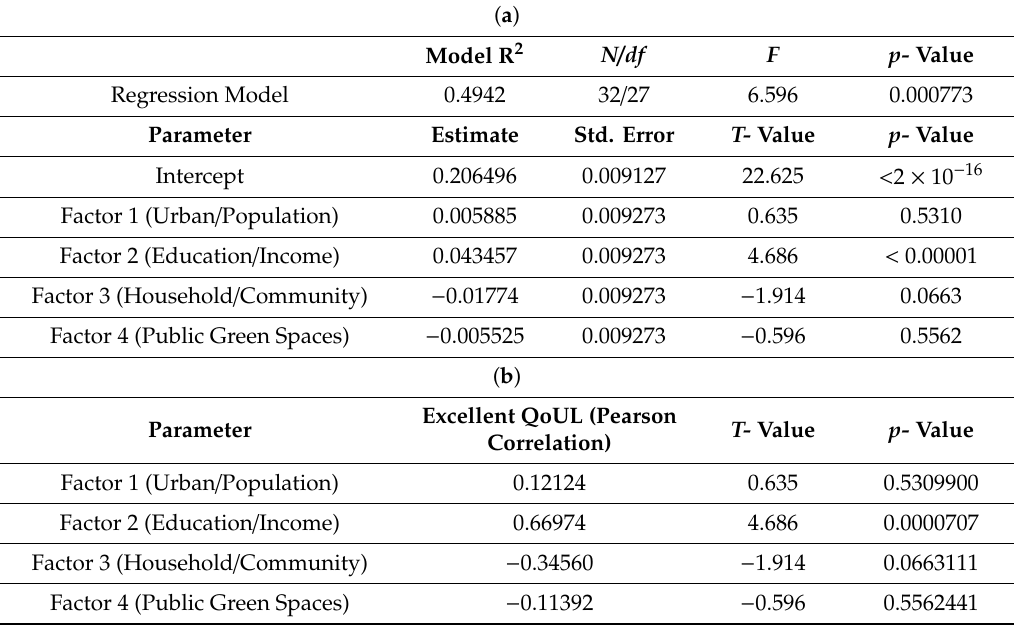
Table 7. Multiple Regression and Partial Correlations for QoUL. ( a ) Results of the multiple regression analysis predicting excellent QoUL from the four factor components. ( b ) Results of the partial correlation analysis predicting excellent QoUL from the four factor